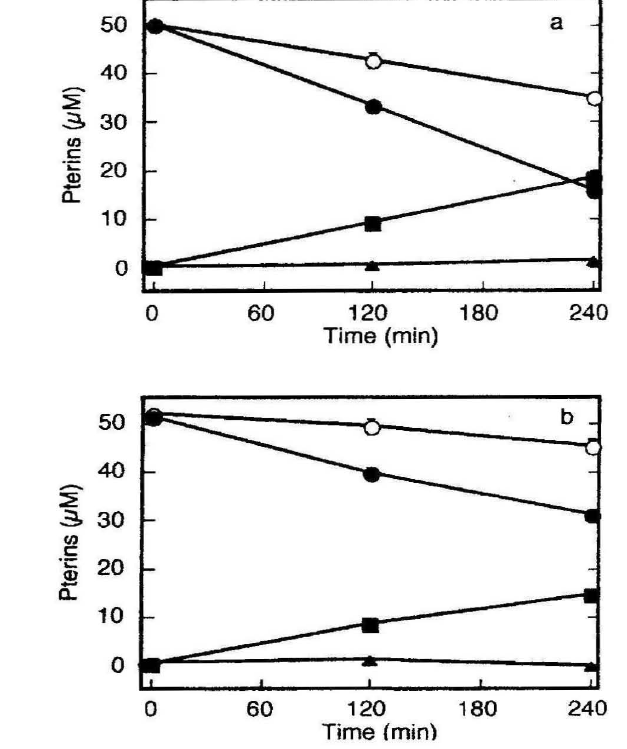
Figure 3: Retention of tetrahydrobiopterin in the cul ture medium with or without culture cells.